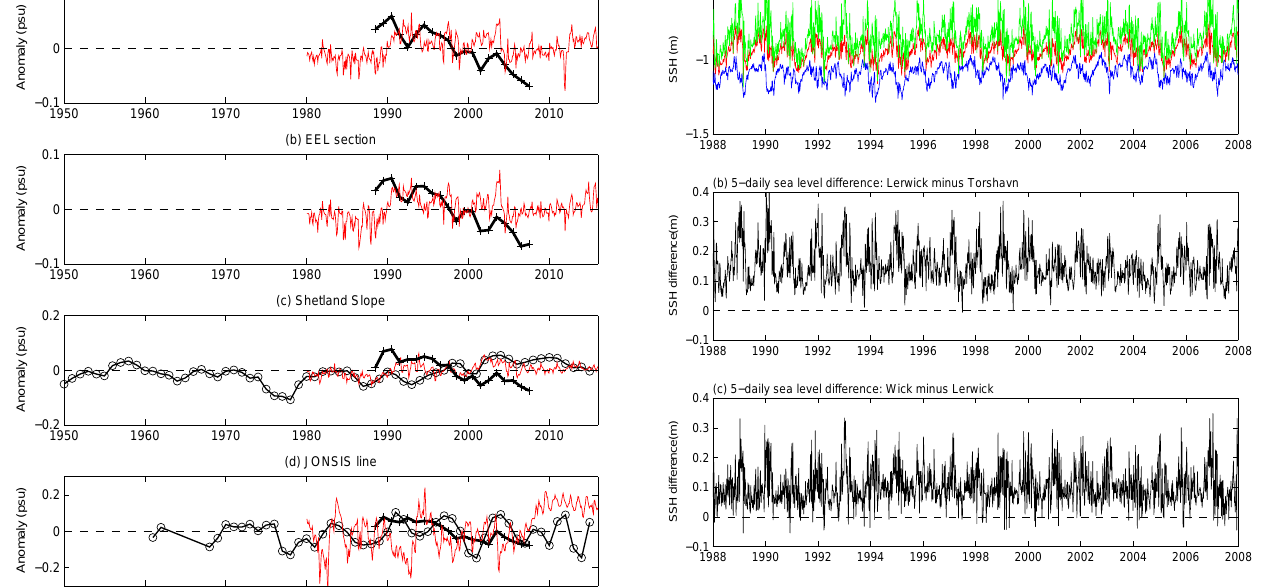
Figure 13. Relative sea surface height at Wick, Lerwick and Tór- shavn, and the differences, 5-day averages over 1988–2007 in